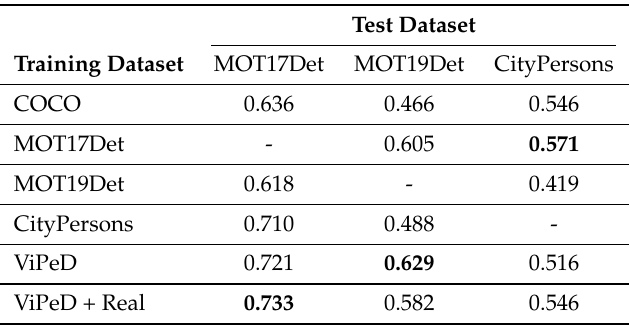
Table 1. Evaluation of the generalization capabilities. The first section of the table reports results obtained training the detector with real-world data, while the latter is related to the model trained over synthetic images. ViPeD + Real refer to the mixed batch experiments with 2/3 ViPeD and 1/3 of COCOPersons. Results are evaluated using the COCO mAP. We report in bold the best results.